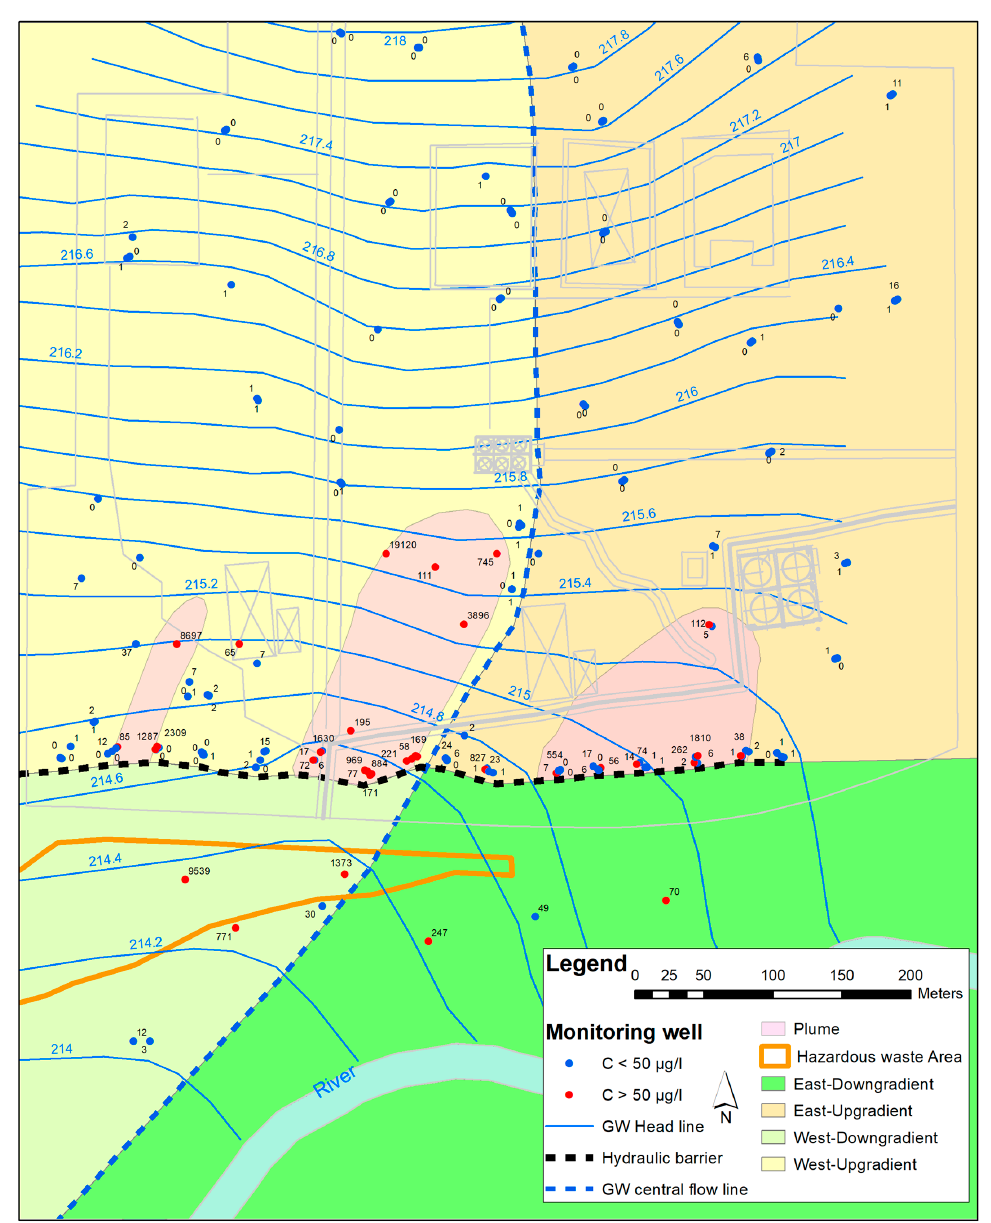
Figure 1. Groundwater flow and monitoring network in the shallow part of the aquifer (<30 m); concentrations refer to the sum of chlorobenzenes. Pink contours show the three narrow plumes located in the upgradient of the hydraulic barrier.